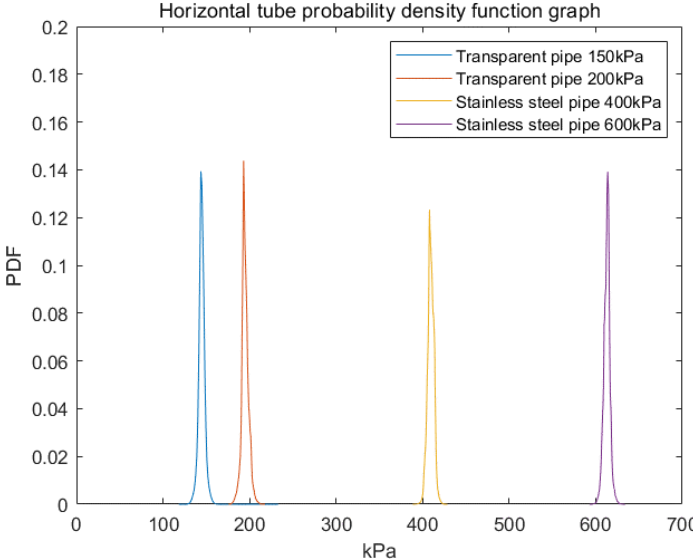
Figure 4. Probability density function diagram at different pressures in horizontal pipeline.